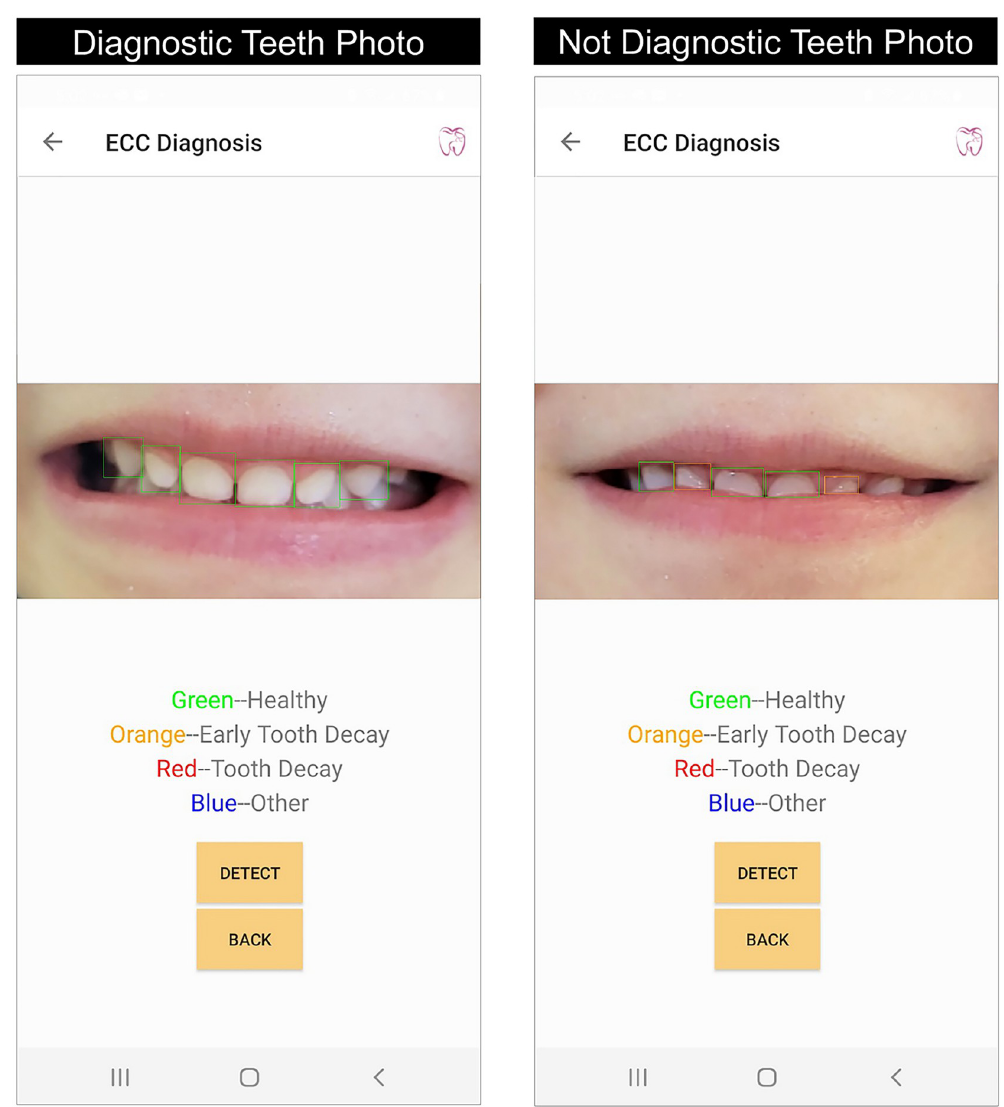
Fig 4. Example of diagnostic and non-diagnostic front teeth photos taken by parents. Examples of a child’s front teeth photo taken by their parents using the AICaries app. The image on the left is clear and diagnostic by including all anatomic structures of the upper front teeth and had a correct diagnosis by AICaries algorithm (all upper front teeth are healthy without tooth decay, marked with green boxes). The image on the right is clear but not diagnostic because the lower lip partially covers the anatomic structure of the upper front teeth. Due to the incomplete tooth picture, AI algorithm did not make correct caries screening for all upper front teeth, two healthy teeth were marked as “Early Tooth Decay” with orange